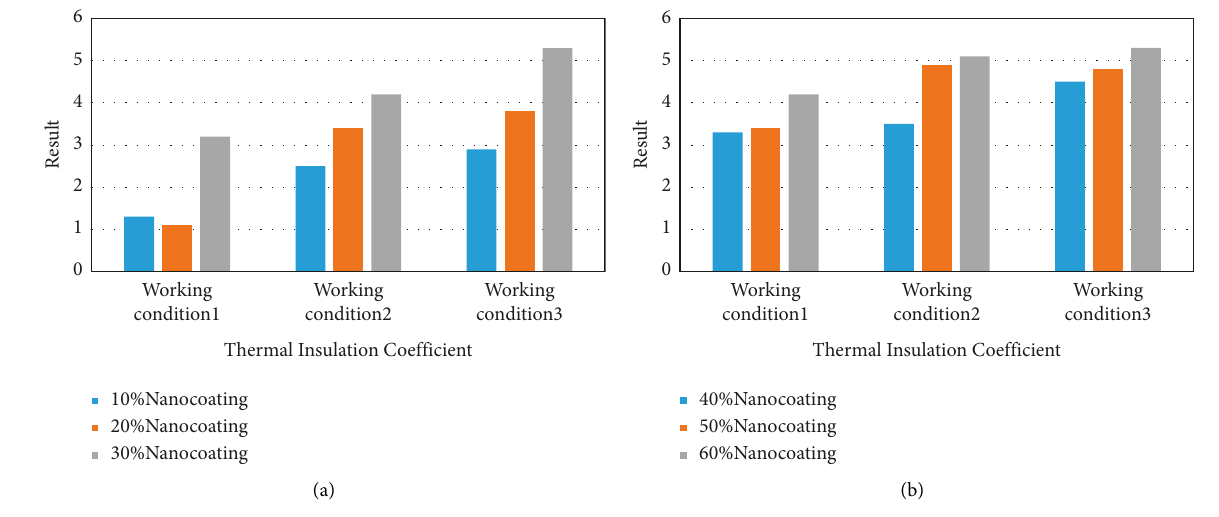
Figure 8: Effect of different nanocoating densities on